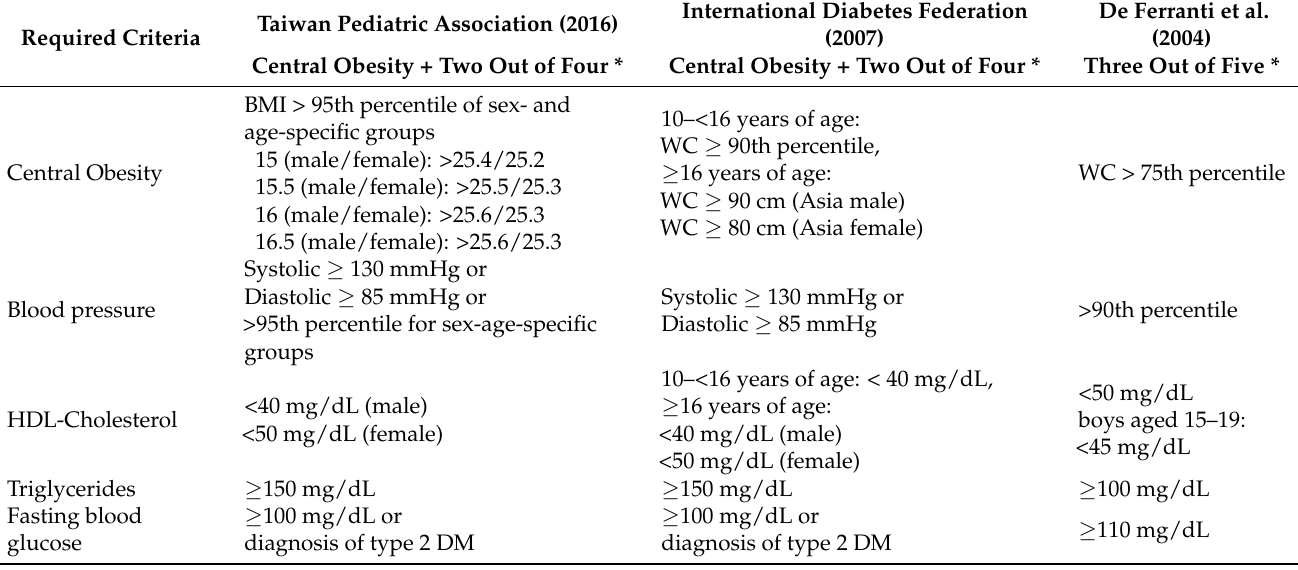
Table 1. Definitions of metabolic syndrome in adolescents by TPA, IDF, and de Ferranti et